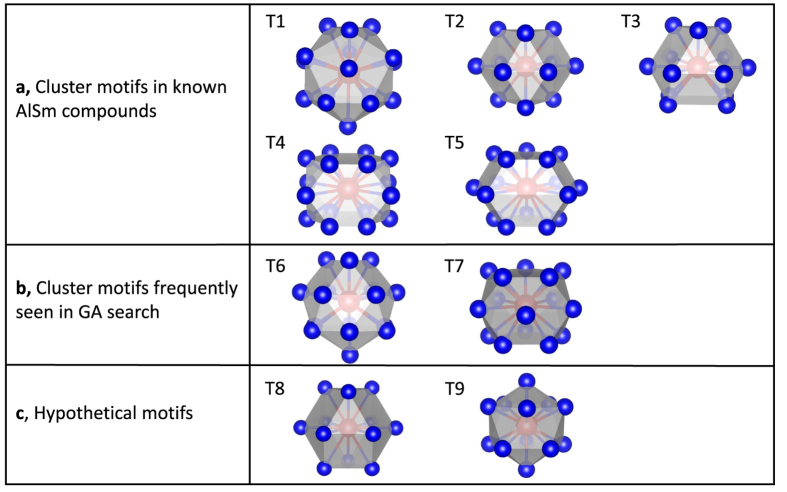
The Sm-centered template motifs containing the first atomic shell.(a) Template motifs extracted from known Al-Sm crystalline compounds51: T1, a typical C.N. 16 Frank-Kasper polyhedron, is extracted from the Al2Sm phase; T2 is extracted from Al3Sm; T3 from γ-Al4Sm; T4 from β-Al4Sm and α-Al11Sm3; T5 is another Sm-centered motif in α-Al11Sm3. (b) Two motifs frequently appearing in new crystalline structures found by GA search. (c) Two additional hypothetical motifs: T8 is the building block for fcc structures; T9 is an icosahedron. Red ball represents for center Sm atom and blue for neighbor atom.